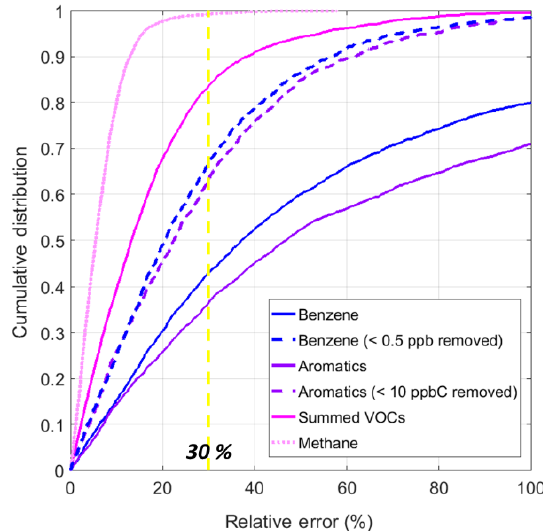
Figure 6. Cumulative distributions of relative sensor error for all fitted testing or validation data; the two dotted lines represent the fitted testing data for benzene and summed aromatics, with the low values removed from the reference